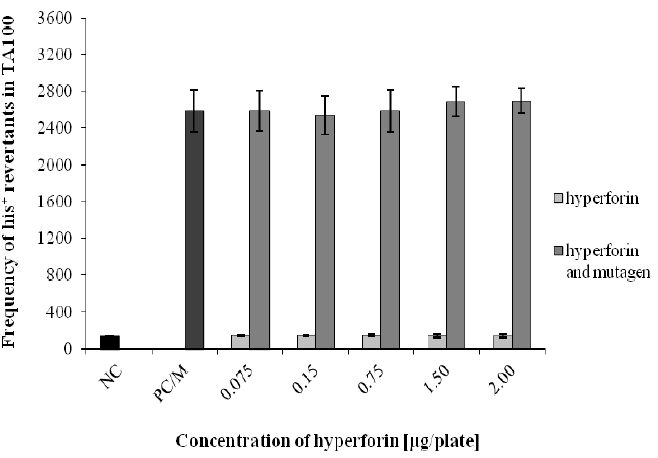
Figure 5. Determination of HF antimutagenic effects using the Ames test—strain S. typhimurium TA100. Data shown are mean ± SD of three repeated experiments. NC = negative control; PC/M = positive control = mutagen = (sodium azide).